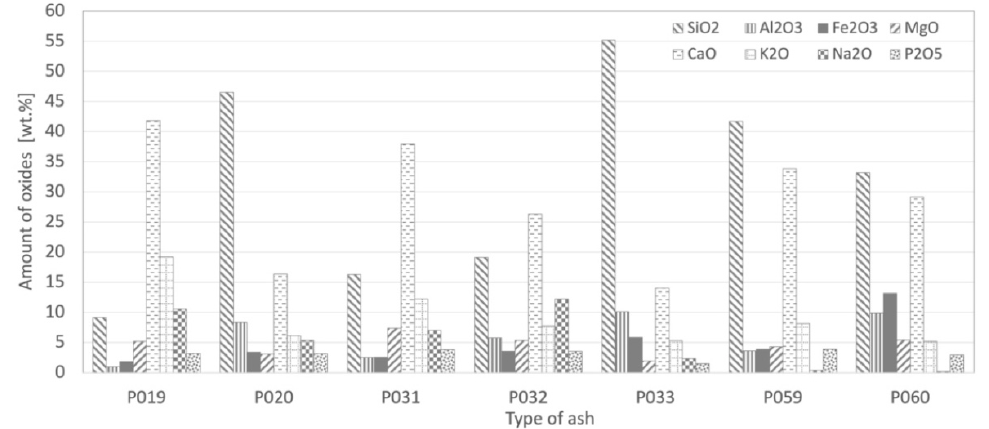
Figure 5. Concentrations of major elements in ash after wood biomass combustion.